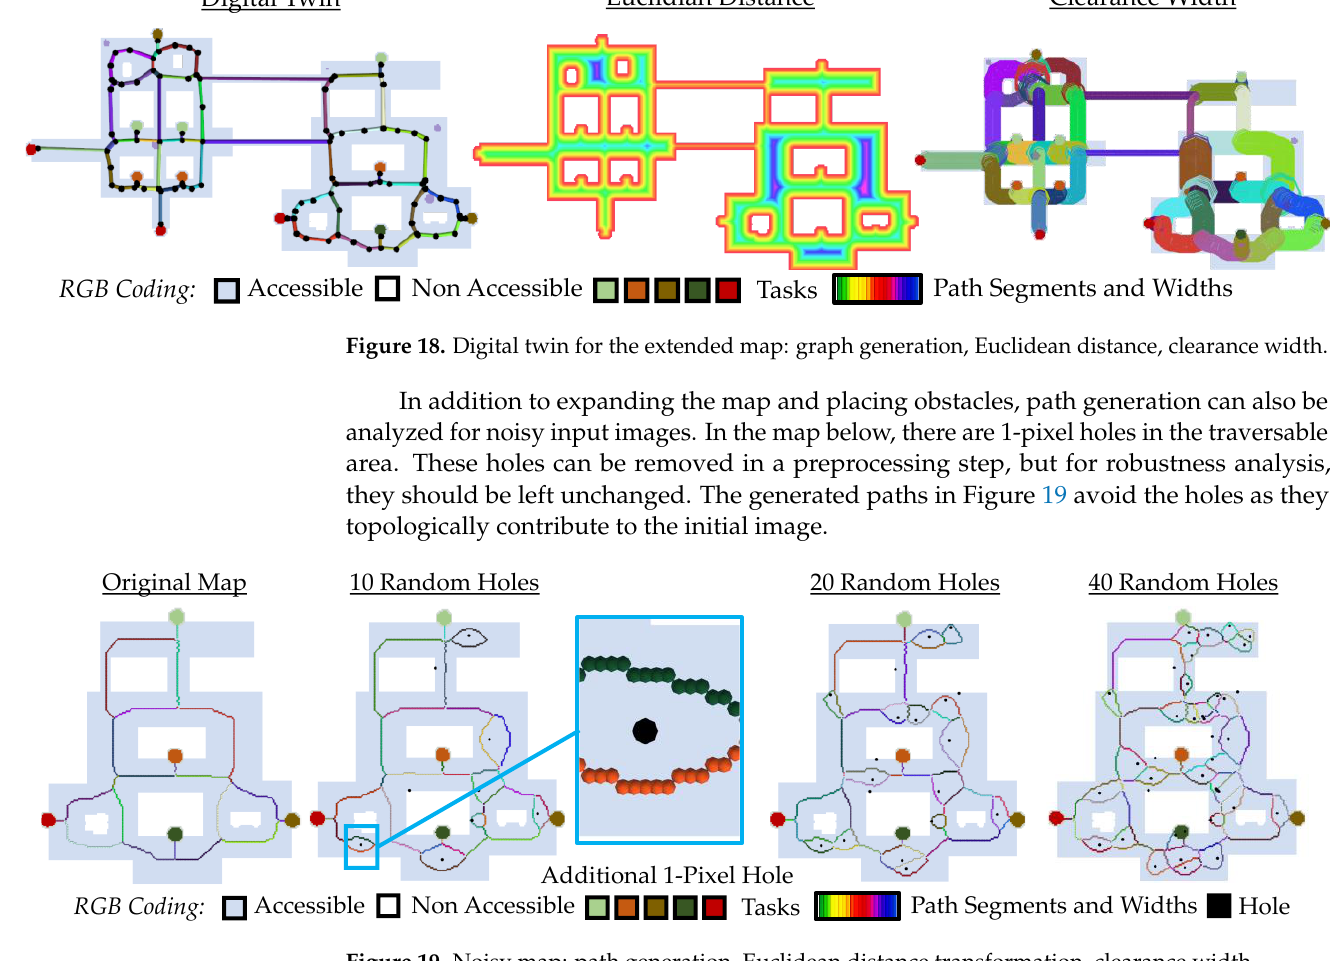
Figure 19. Noisy map: path generation, Euclidean distance transformation, clearance width.